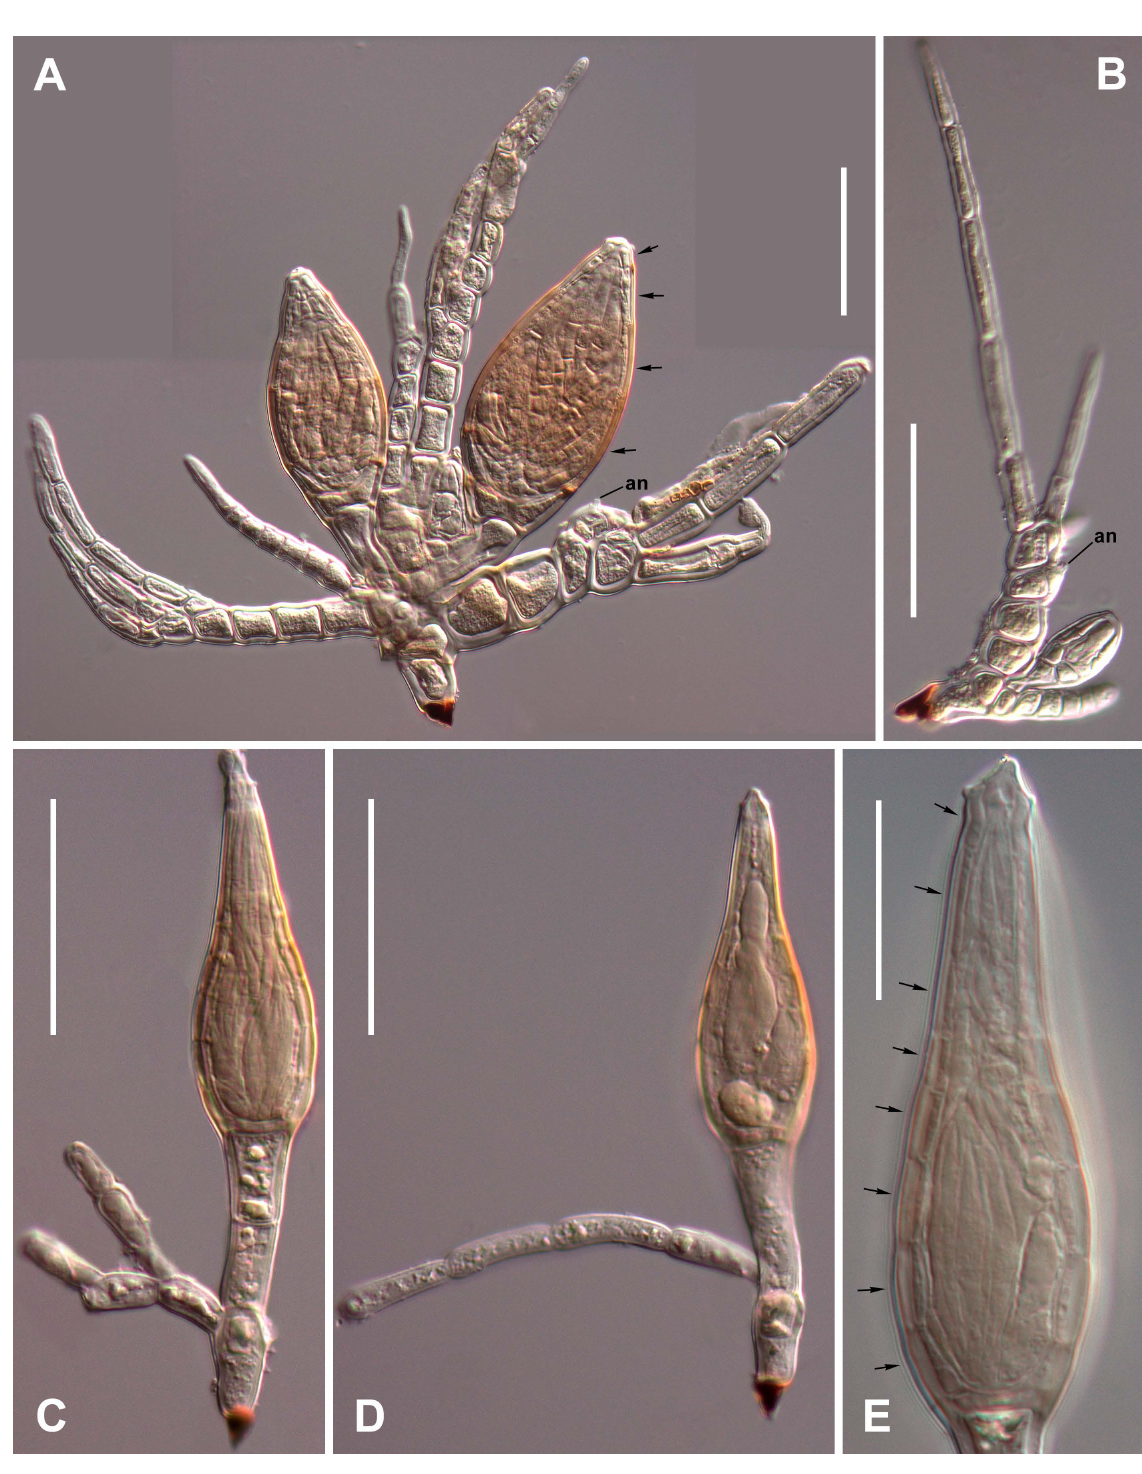
Fig. 5. Compsomyces spp. A – B . C. lestevae Thaxt. A . Mature thallus showing antheridium (an) and perithecial wall cells (arrows). B . Immature thallus showing antheridium (an). – C – E . C. verticillatus (Thaxt.) Thaxt. C – D . Mature thalli. E . Detail of perithecium labelling eight wall cells (arrows). Scale bars: A–D = 50 µm; E = 20 µm. Photographs from slides ZMUC C-F-122939 (A–B), and ZMUC C-F- 124184